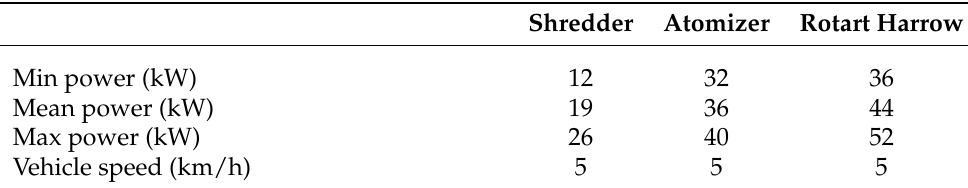
Table 2. Relevant characteristics of the proposed implement-related